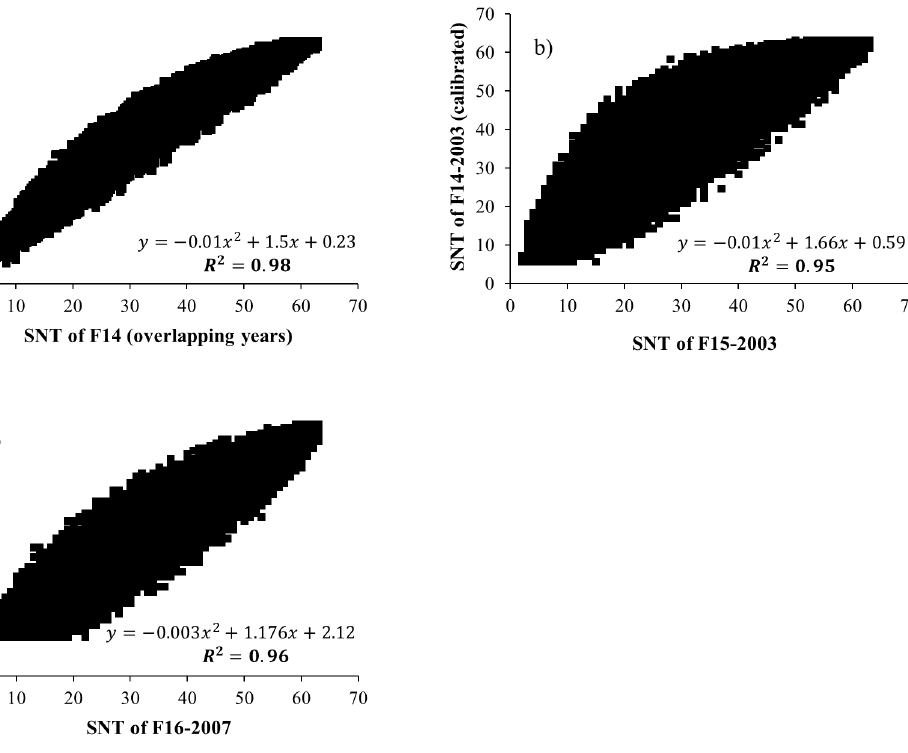
Figure 3. Regression coefficients of DMSP-OLS SNT between ( a ) F12 and F14, ( b ) F14-2003 (calibrated) and F15-2003 and ( c ) F15-2007 (calibrated) and F16-2007.